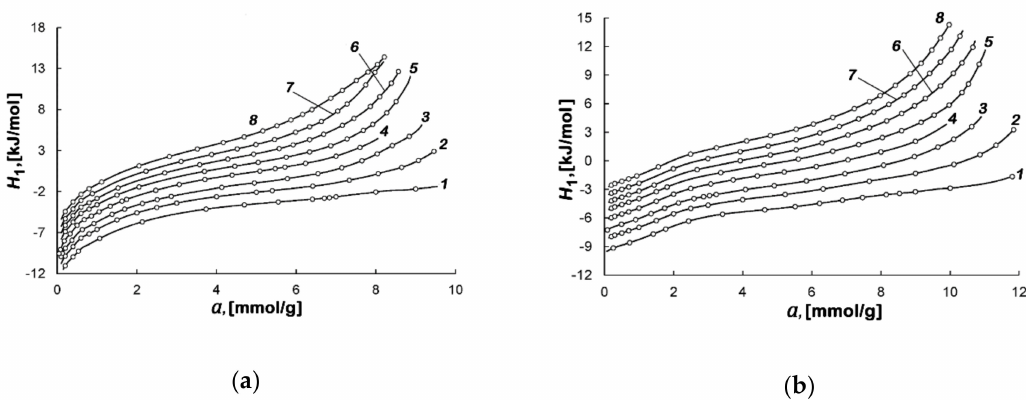
Figure 8. Dependence of the di ff erential molar isosteric enthalpy of the methane-AC-4 ( a ) and methane-AC-6 ( b ) adsorption systems on the value of adsorption at temperatures, K: 178.00 ( 1 ), 216.00 ( 2 ), 243.00 ( 3 ), 273.15 ( 4 ), 300.00 ( 5 ), 320.00 ( 6 ), 340.00 ( 7 ), and 360.00 ( 8 ). Symbols indicate the experimental data; solid lines are the smoothing spline curves.